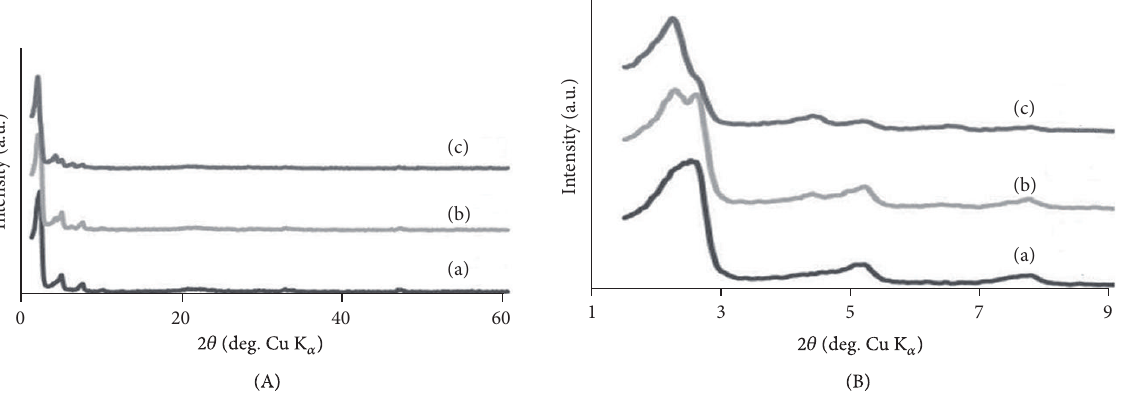
ONTs, and (c) V ONTs at two different ranges of 2